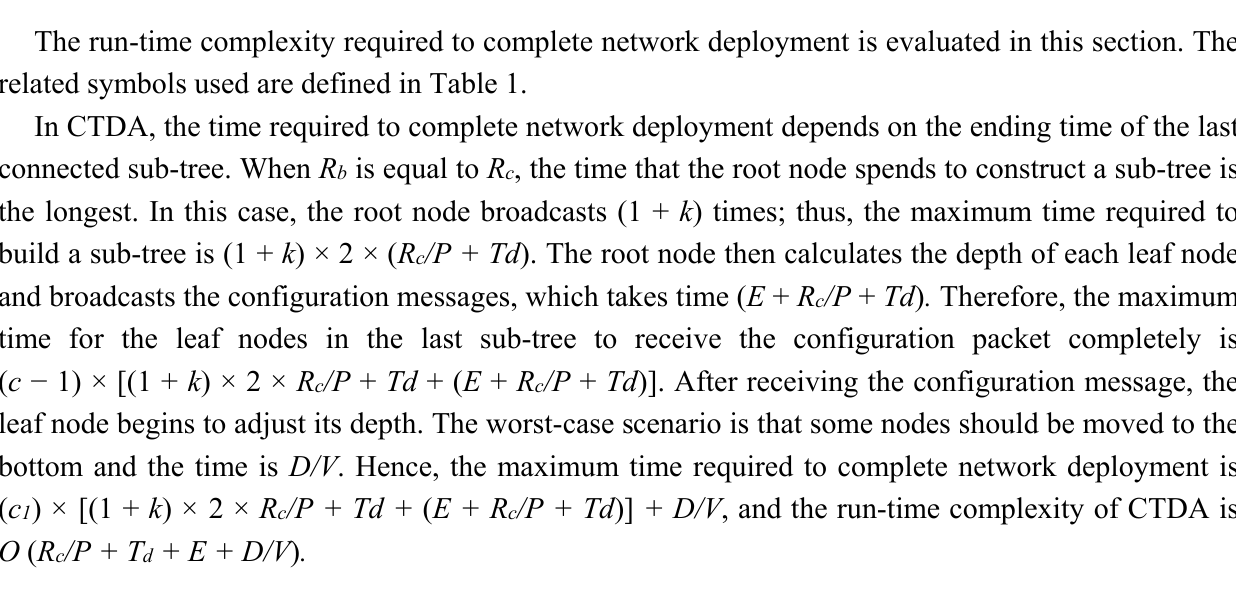
Table 1. Definition of symbols in run-time complexity